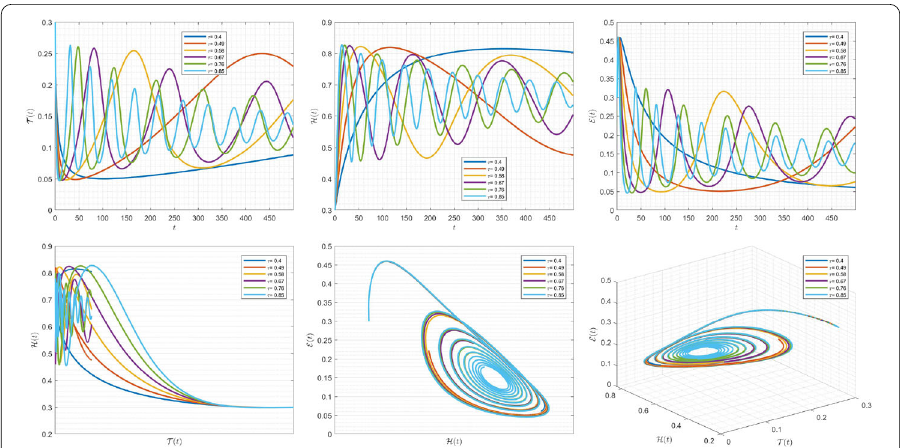
Figure 17 Simulations for solving (75) using (79) along with ( T (0), H (0), E (0)) = (0.3,0.3,0.3) and β 12 = 0.745